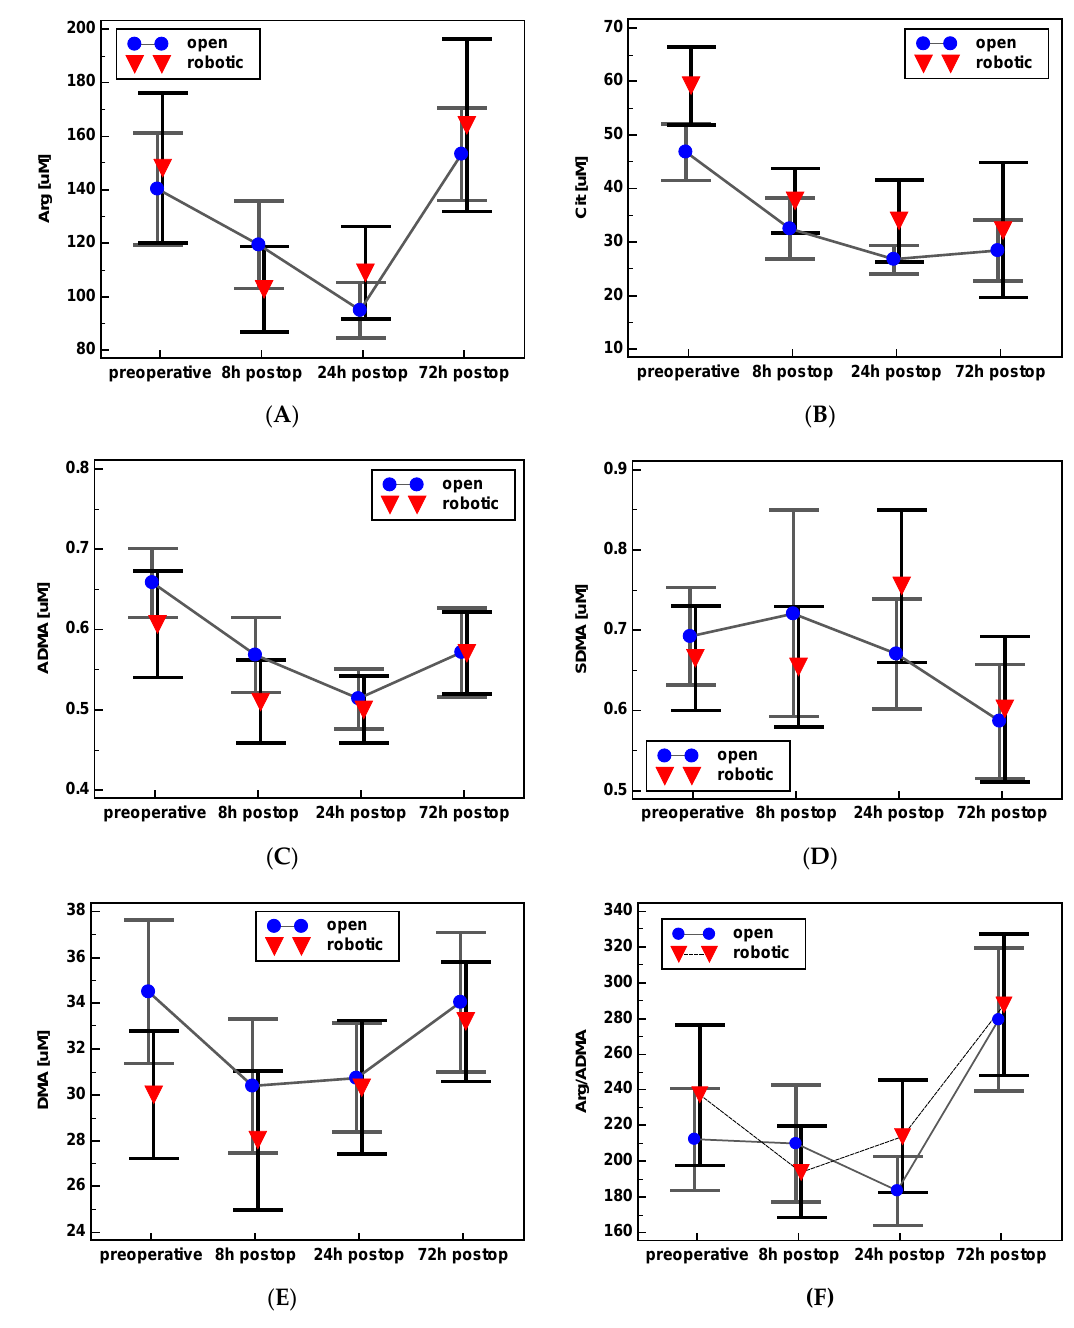
Figure 7. Impact of surgery type on postoperative dynamics of L-arginine / NO pathway metabolites: ( A ) Arginine—Arg; ( B ) citrulline—Cit; ( C ) asymmetric dimethylarginine—ADMA; ( D ) symmetric dimethylarginine—SDMA; ( E ) dimethylamine—DMA; ( F ) Arg / ADMA. Data presented as means with a 95% confidence interval and analyzed using repeated measures ANOVA. Postop: